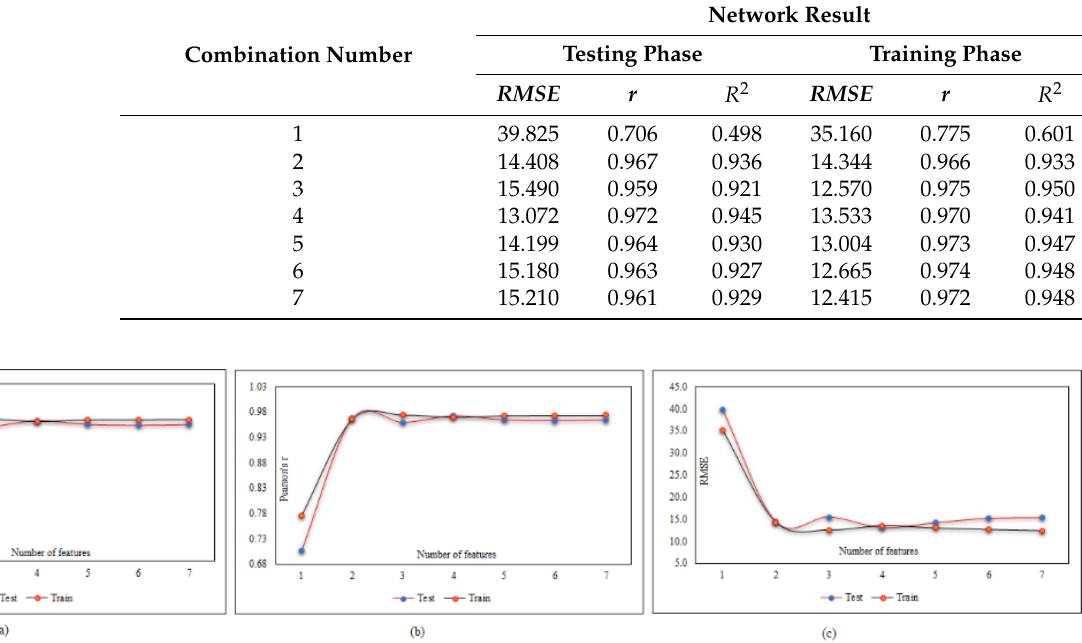
Figure 21. MPF adjustment based on the iteration number: ( a ) effect of the iteration number on ( R 2 ), ( b ) effect of the iteration number on (r), and ( c ) effect of the iteration number on ( RMSE ). Table 9. The calculated accuracy criteria for the performance of the implemented models (Popula- tion = 125).